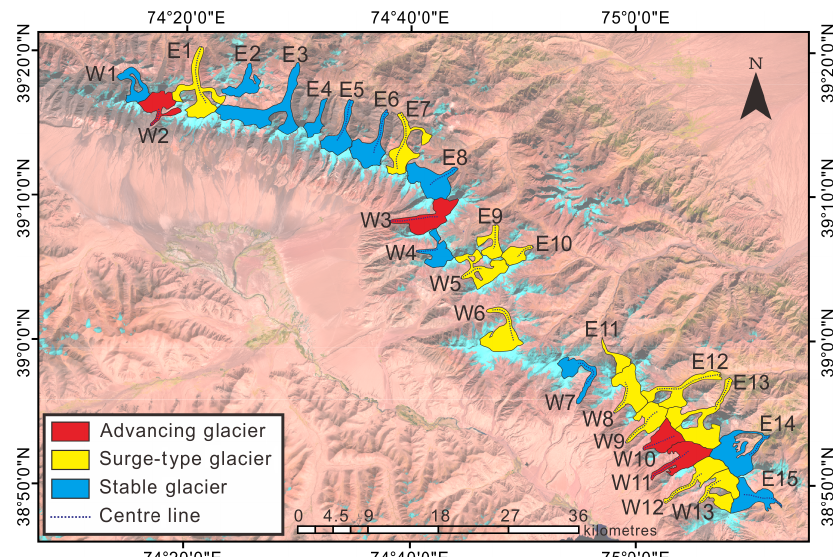
Figure 2. Studied glaciers and their numbers in this